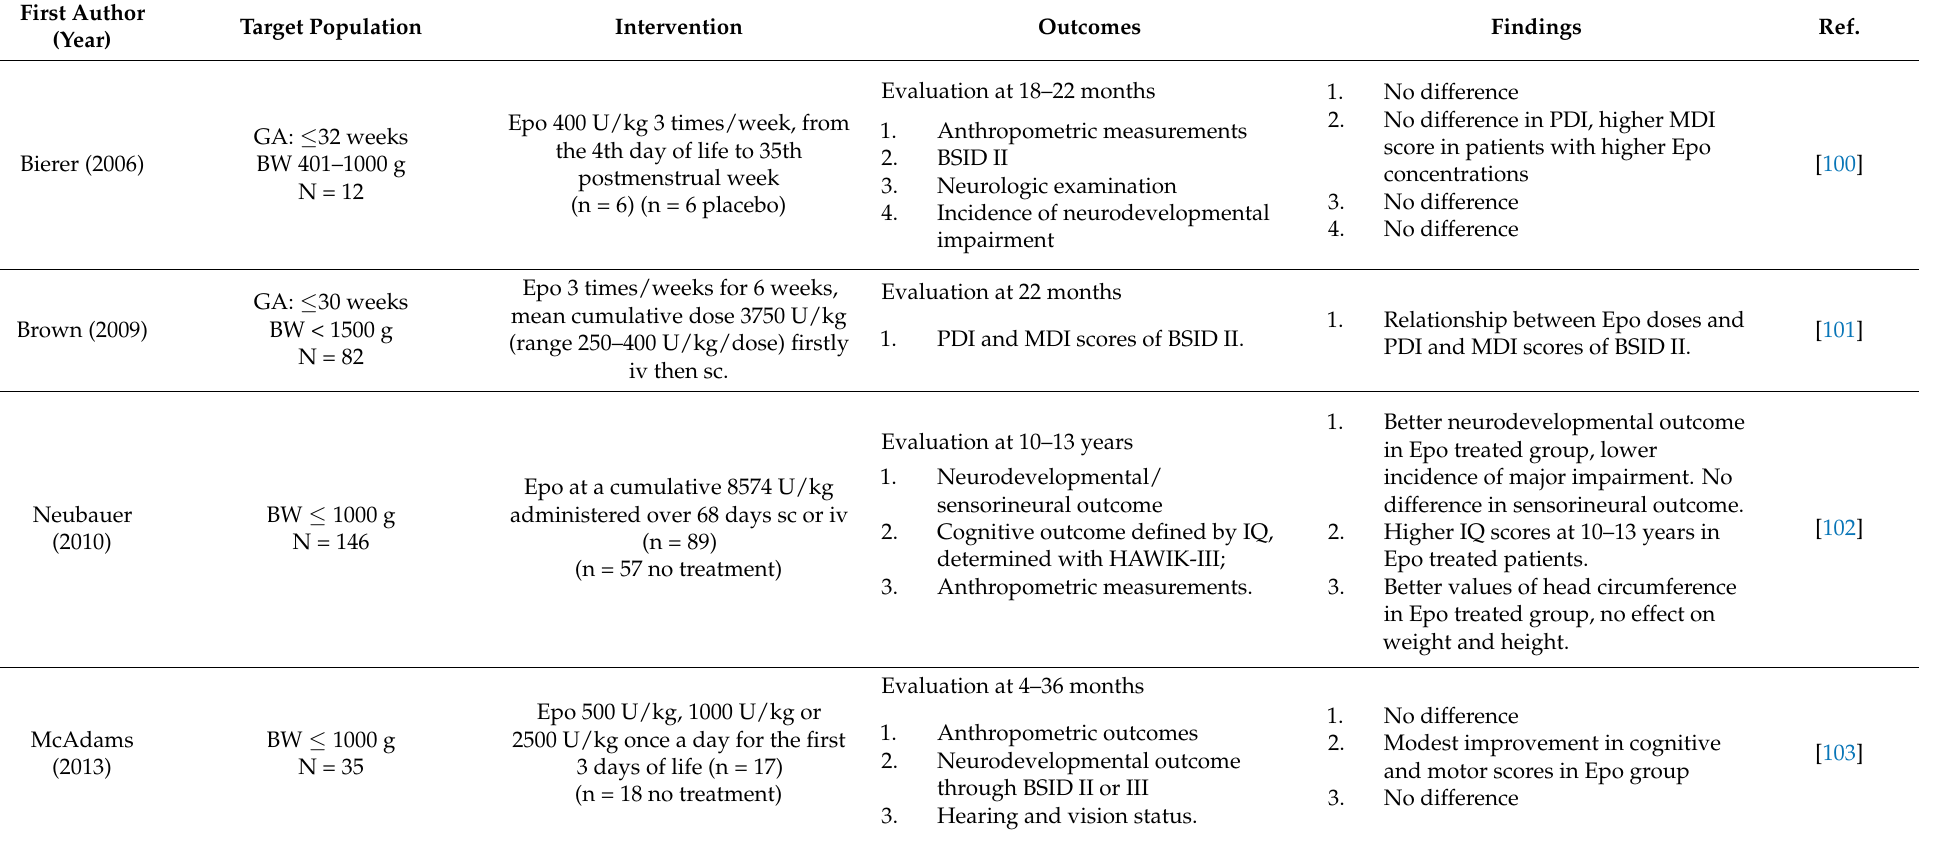
Table 1. Erythropoietin (Epo) administration in preterm